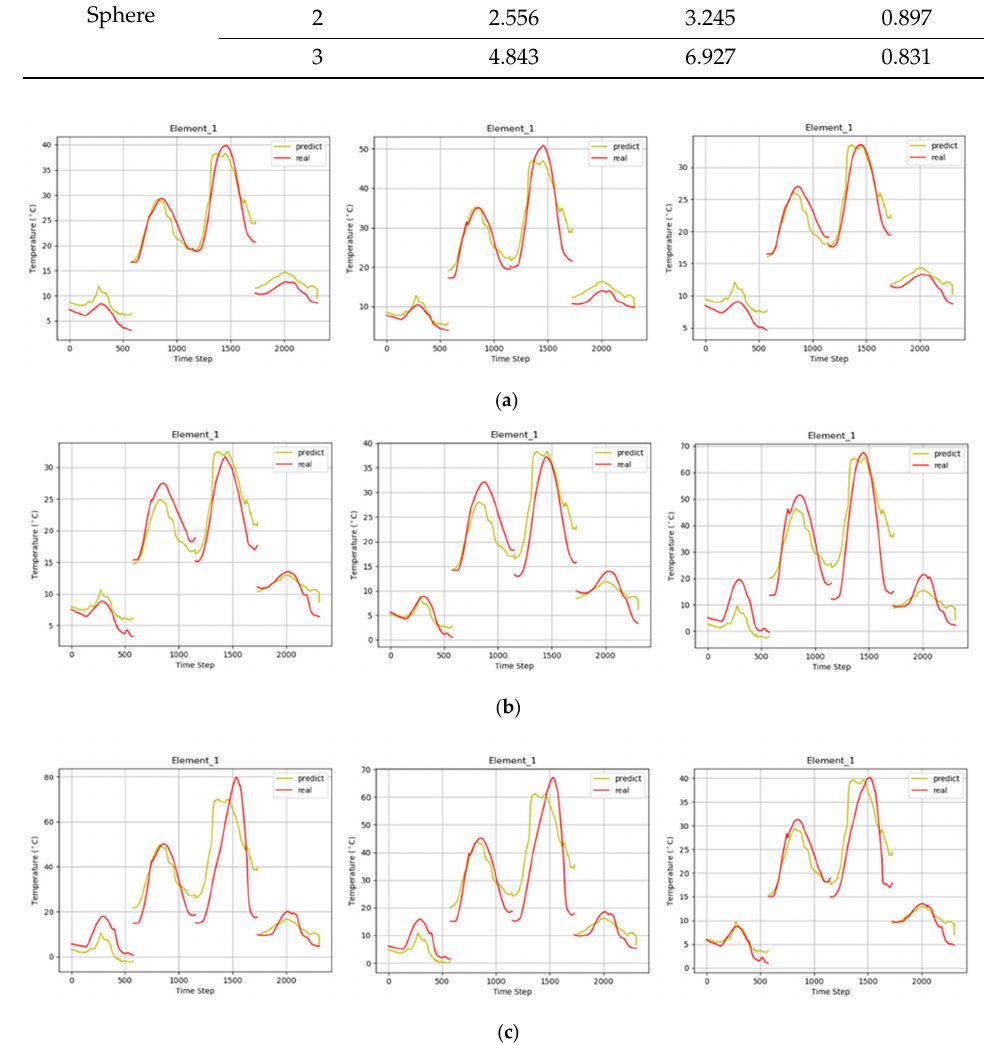
Figure 11. Multi-object temperature field prediction effects. Fitting of different materials of ( a ) box; ( b ) cylinder; and ( c ) sphere.